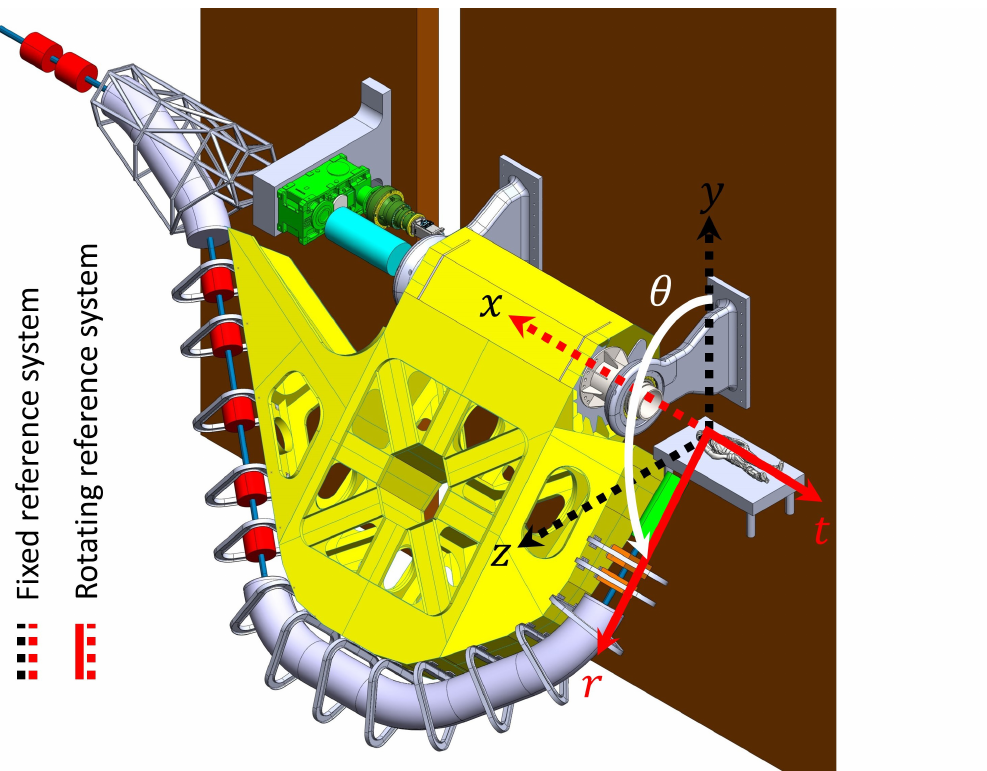
Figure 3. Cartesian reference systems used in the study of the deformations of the structure and its main supports: a fixed system of reference, dotted, and a rotating system of reference highlighted in red. The structure is rotated by θ = 135°, where θ is the angle measured from y to r .